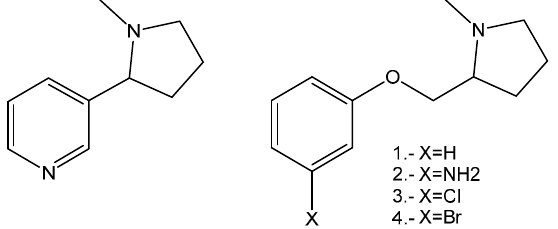
Figure 2. Pyrrolidine phenyl ether derivatives used in this work (right) and nicotine structure (left).